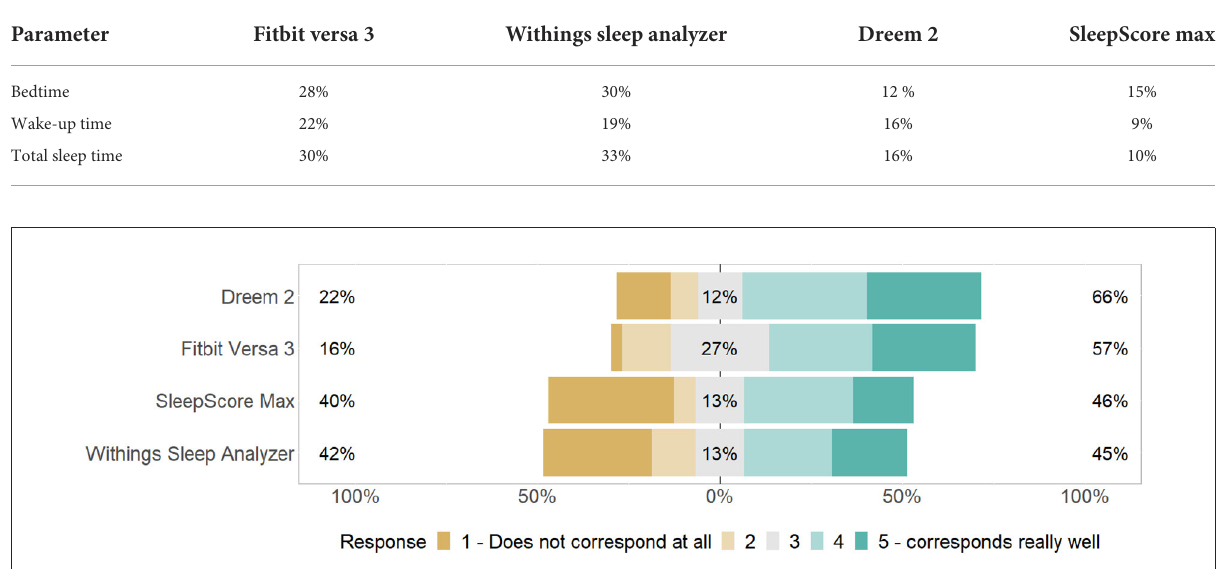
TABLE 3 How often the sleep parameters from each device were experienced as inaccurate.